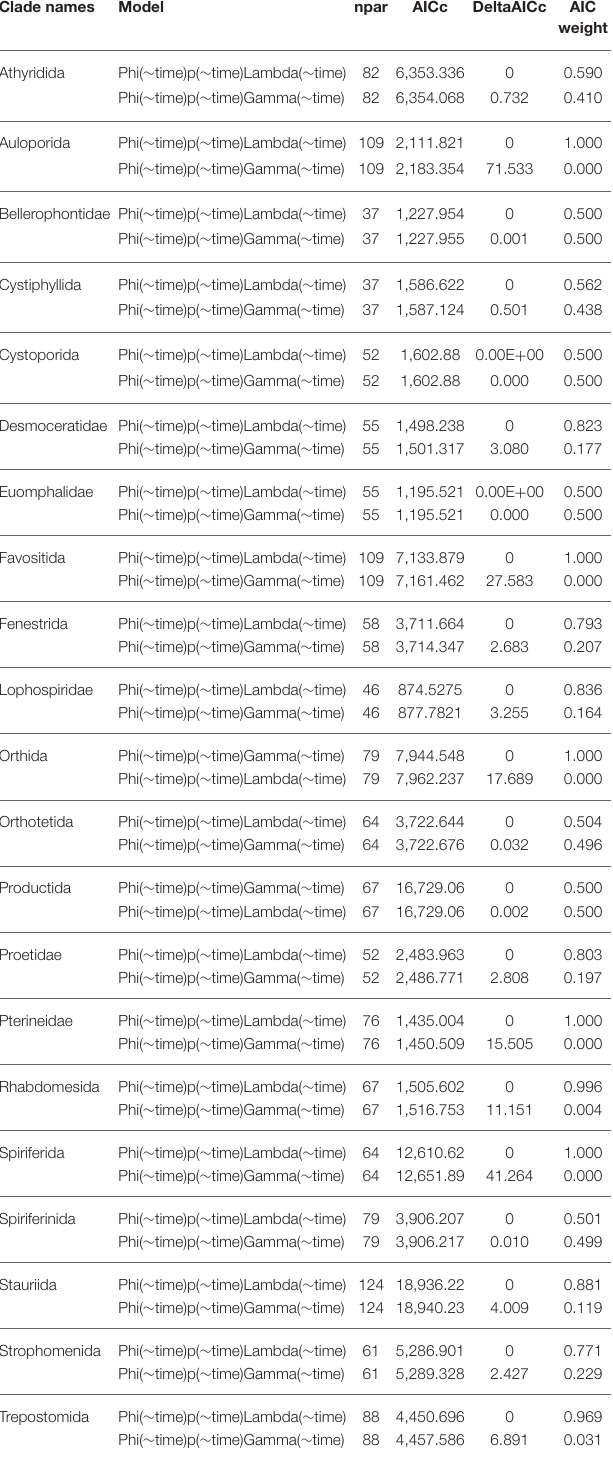
TABLE 1 | Results of “survival (Phi) and seniority (Gamma)” and “survival (Phi) and population growth (Lambda)” models simulations for all the 21